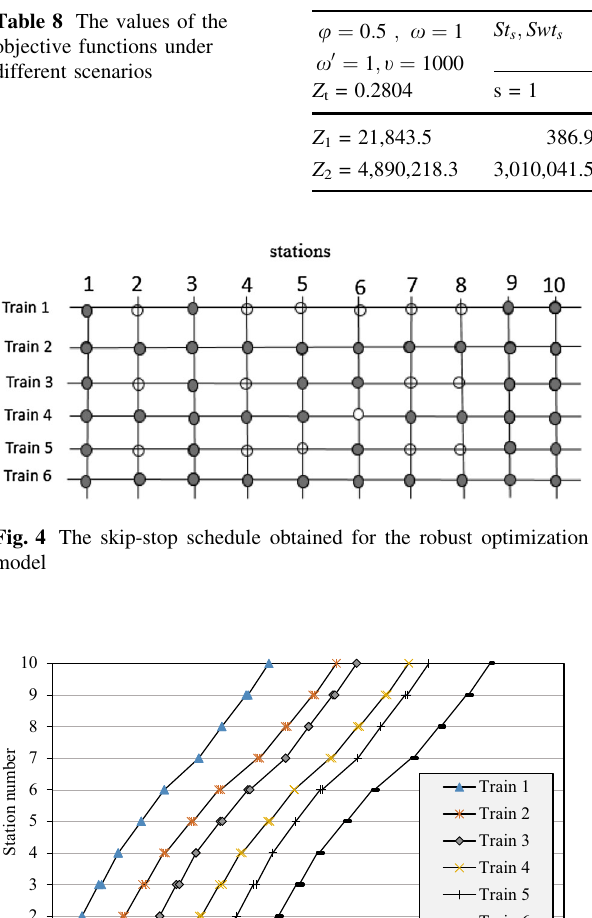
Table 9 Sensitivity analysis of train capacity parameter Parameters Values